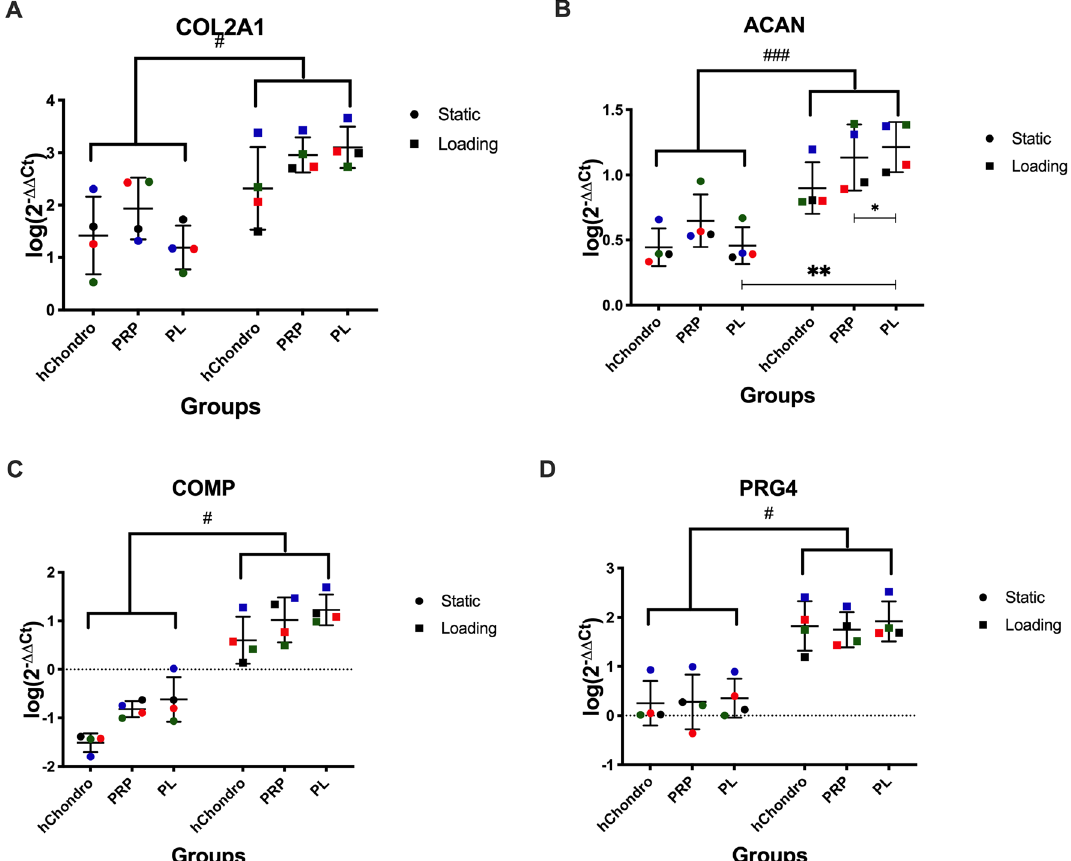
Figure 4. Influence of PRP-Gel, PL supplementation and multi-axial loading on mRNA levels of COL2A1 ( A ), ACAN ( B ), COMP ( C ), PRG4 ( D ). Relative gene expression (log(2 −ΔΔCT )) was transformed by log(10) and visualized in scatter dot plots with different colors for each donor and lines at mean ± SD, # defines significance between static and loaded, * defines significance between specific groups. One symbol = p < 0.05, two symbols = p < 0.01, three symbols = p < 0.001.